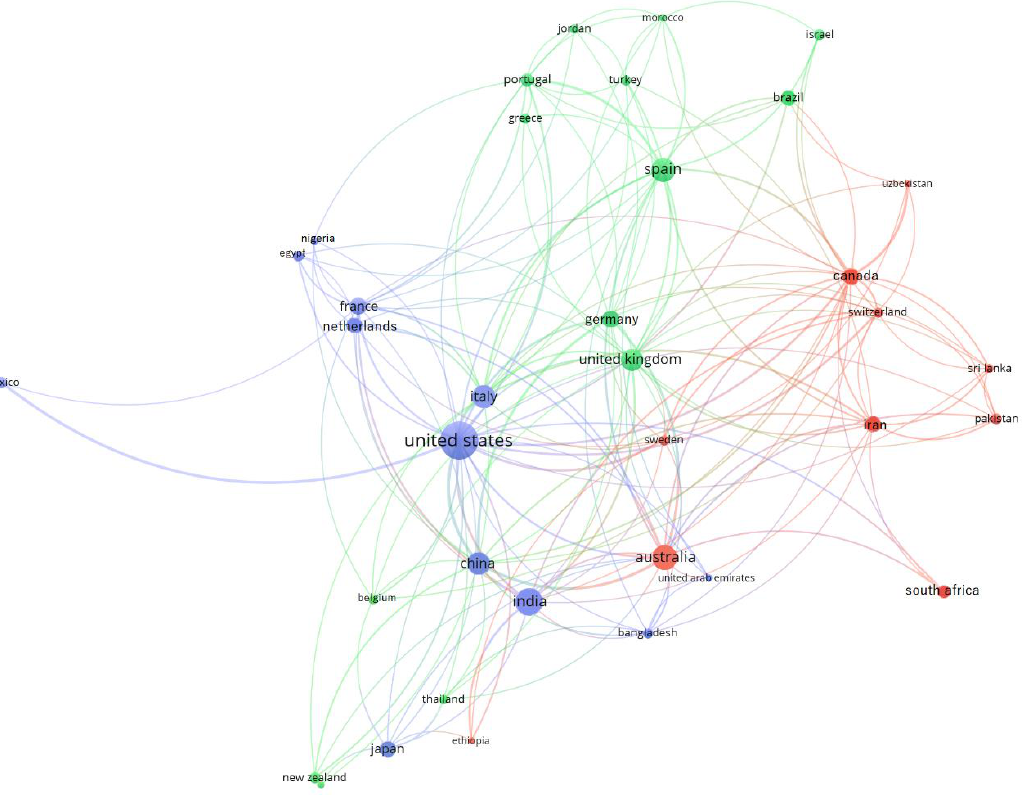
Figure 4. Main relationships between countries in SI research.